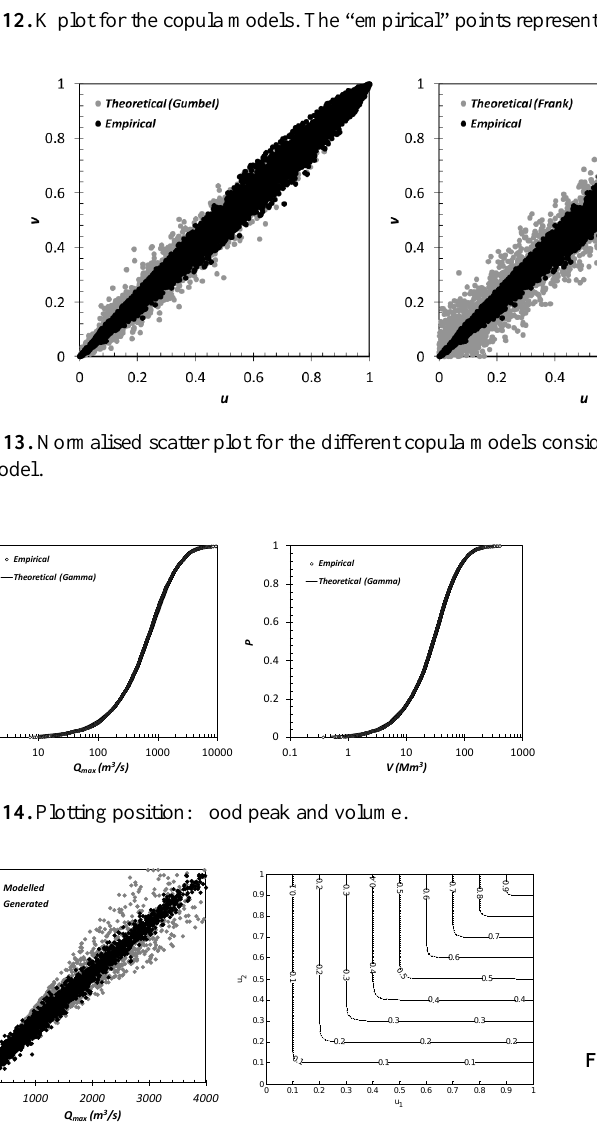
Figure 15. Comparison between a sample generated from the Gum- bel copula and the observed data (left) with the copula contours (right).